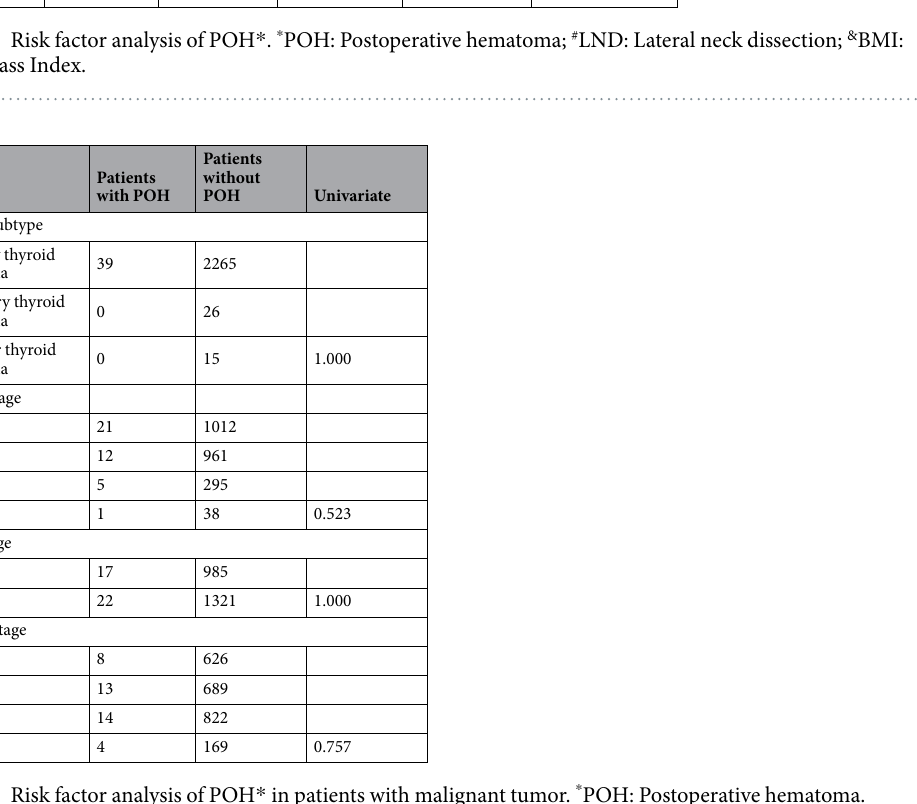
Table 4. Risk factor analysis of POH * in patients with malignant tumor. * POH: Postoperative